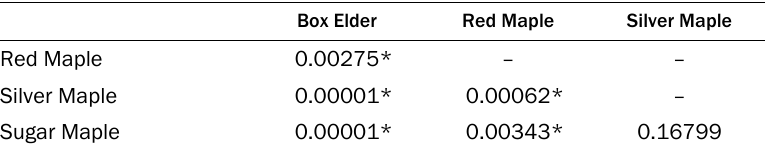
Table 4. Pairwise Comparisons Using Wilcoxon Rank Sum Test: